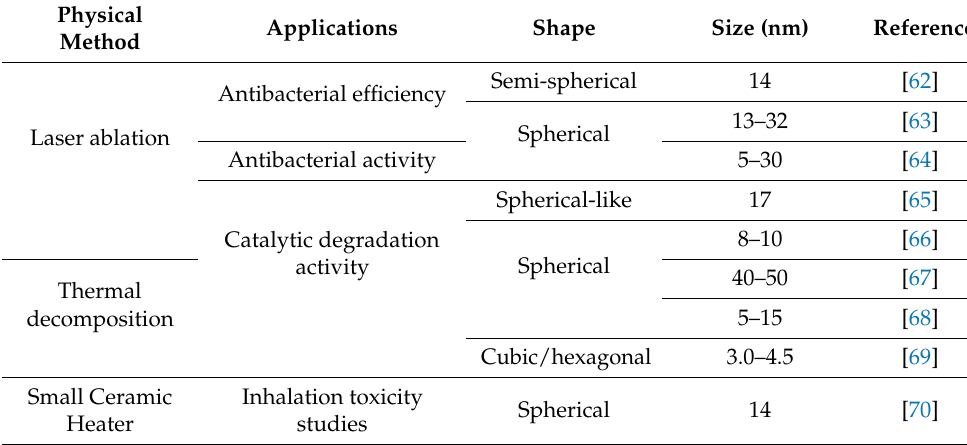
Table 1. A list of various physically synthesized Ag